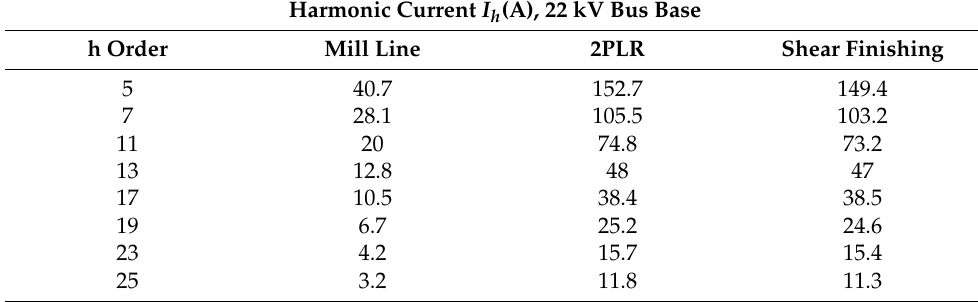
Table 3. Harmonic injection on 3.3 kV